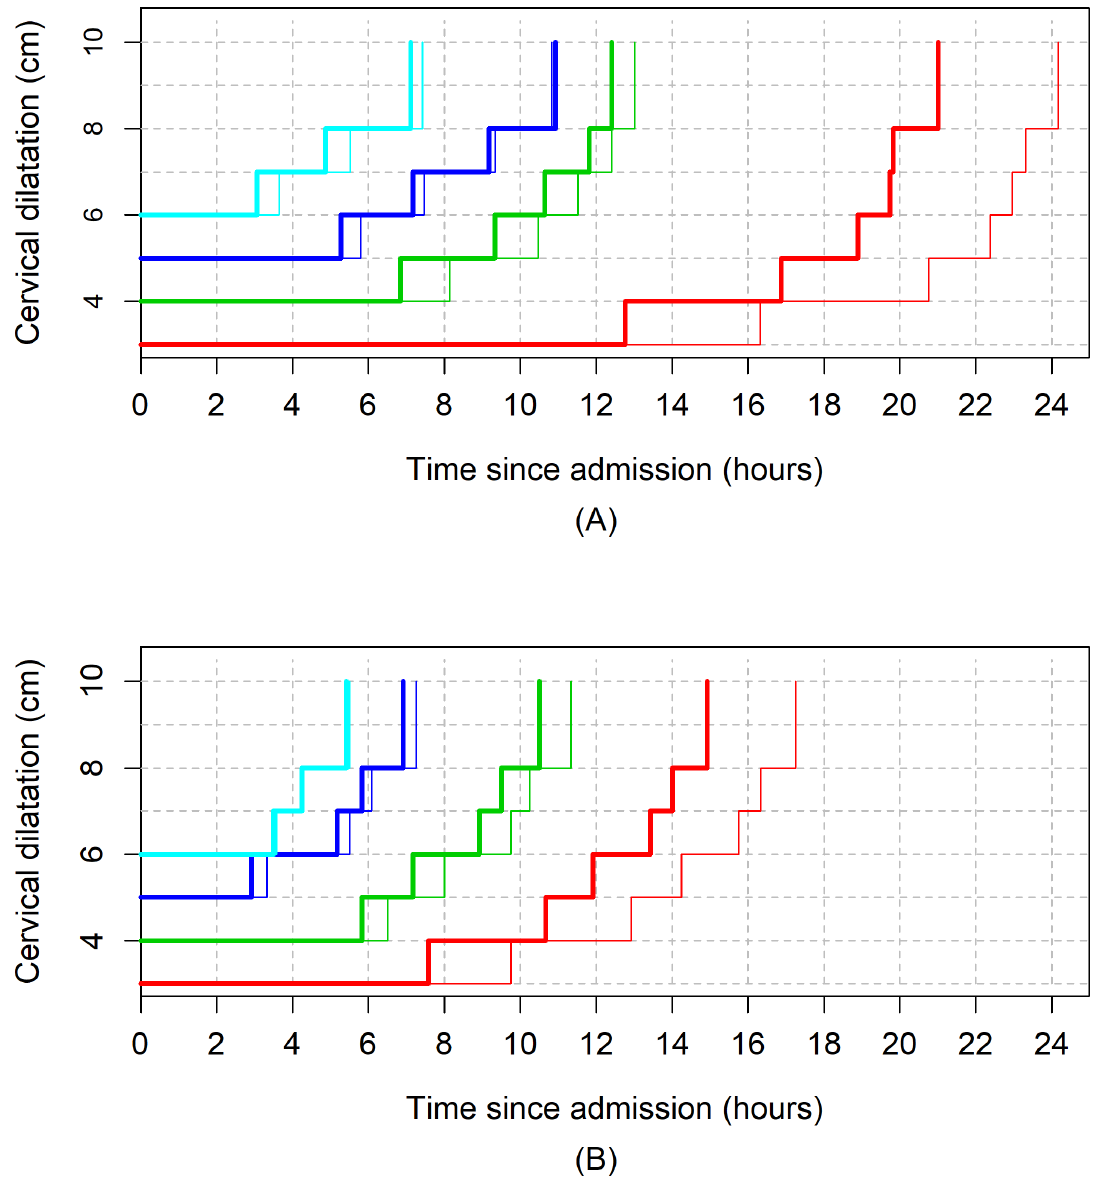
Fig 9. The 95th percentiles of cumulative duration of labour in parity = 2+ women by augmentation. (A) Survival analysis. (B) Multistate Markov analysis. Thin lines: all women. Thick lines: women with oxytocin augmentation